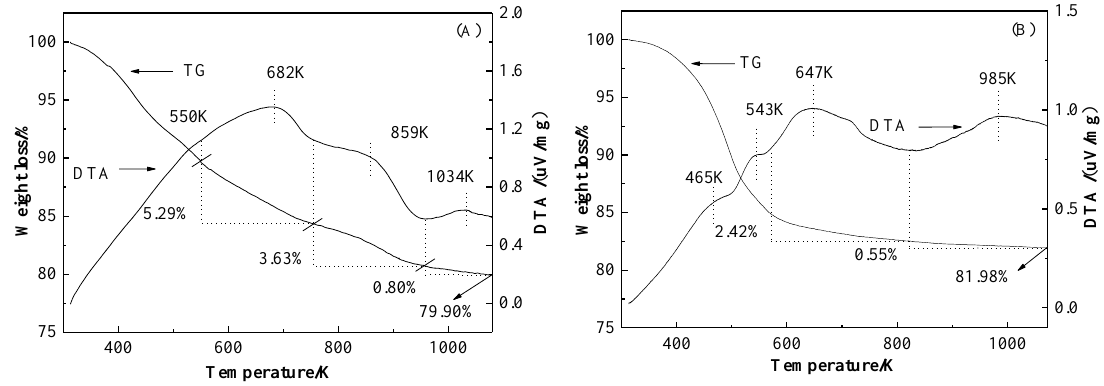
Figure 5. The TG-DTA plots of the used HY ( A ) and HY-H 4 EDTA-NH 4 OH-TPAOH ( B ) zeolites after 24 h reaction.